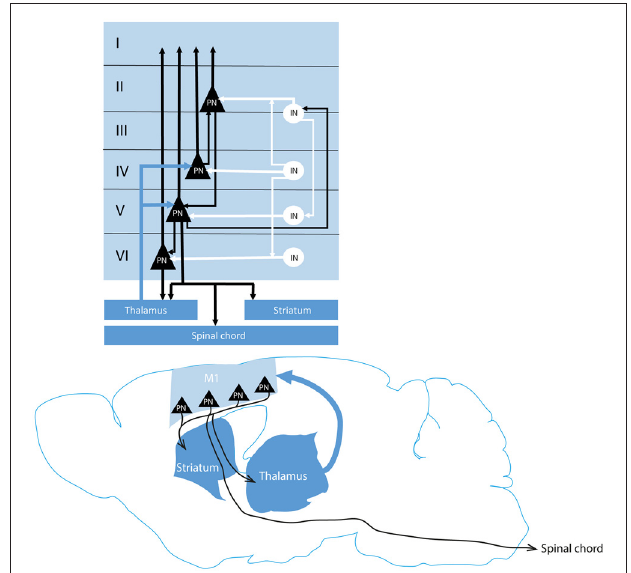
FIGURE 1 | Classical representation of the cortico-subcortical and intracortical motor networks. Thalamic projections to the cortex (blue arrow) reach cortical pyramidal neurons (black triangles) in layer IV and V which contact respectively the layer II/III PN and layer VI PN and inhibitory interneurons (white circle) in the layer II/III. Layer II/III PN contact then PN in the layer V. Layer V and VI PN project to subcortical structures (dark blue). An inhibitory intracortical loop (white) is formed by the inhibitory interneurons in parallel to the excitatory circuitry (black) to prevent epileptiform activity of the cortex. M1, motor cortex; PN, pyramidal neuron; IN,